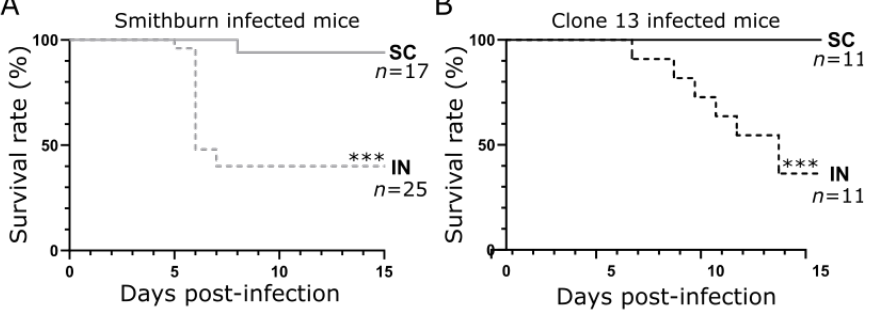
Figure 1. Survival rates of BALB/c mice intranasally or subcutaneously infected with the SB or Cl.13 vaccine strain. Kaplan–Meier survival plots of BALB/c mice subcutaneously (SC) or intranasally (IN) inoculated with 1 × 10 3 PFU of the Smithburn ( A ) or Clone 13 ( B ) strain. For both RVFV strains, the IN route of infection led to higher mortality rates than SC inoculation. Survival curves were compared using the Gehan–Breslow–Wilcoxon test (***: p < 0.001). n: number of mice per condition from, at least, two independent experiments.